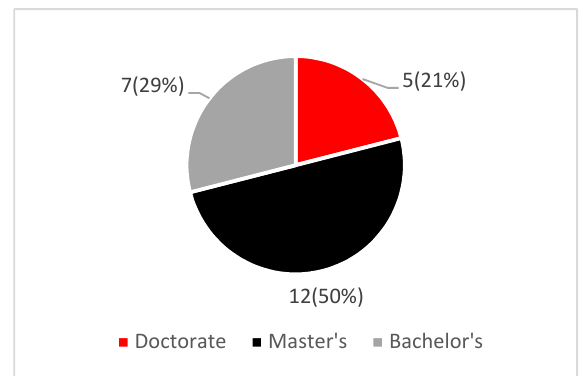
Figure 1. Participant Education Levels.